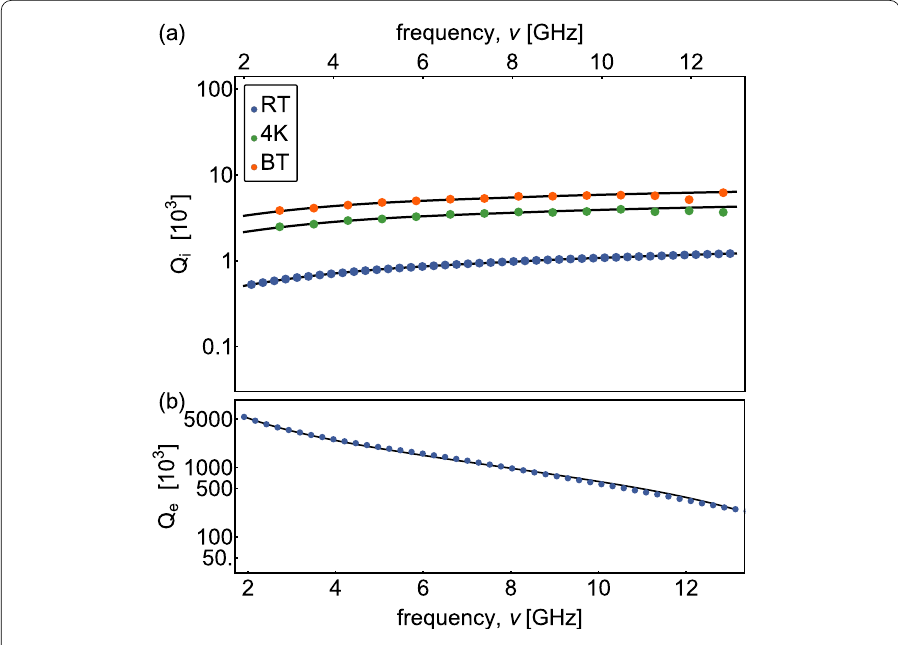
Figure 4 Frequency and temperature dependence of quality factors of aluminum coaxial line CC141Al. (a) Measured internal ( Q i ) and (b) external quality factors ( Q e ) of coaxial line CC141Al versus frequency ν extracted from the spectra measured at RT (blue dots), at 4K (green dots) and BT (orange dots). The black lines are fits to the loss model discussed in the text.